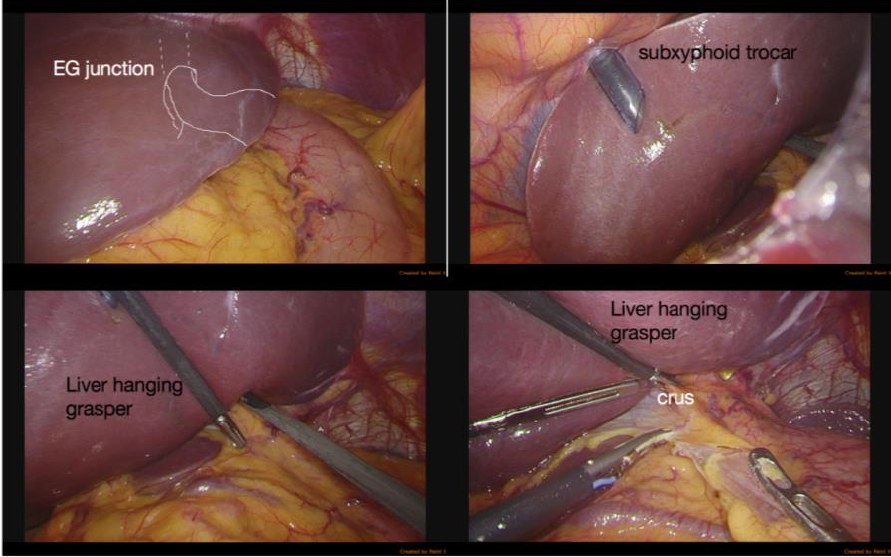
Figure 4. “Sling and expose” maneuver of liver during laparoscopic gastric conduit harvest.